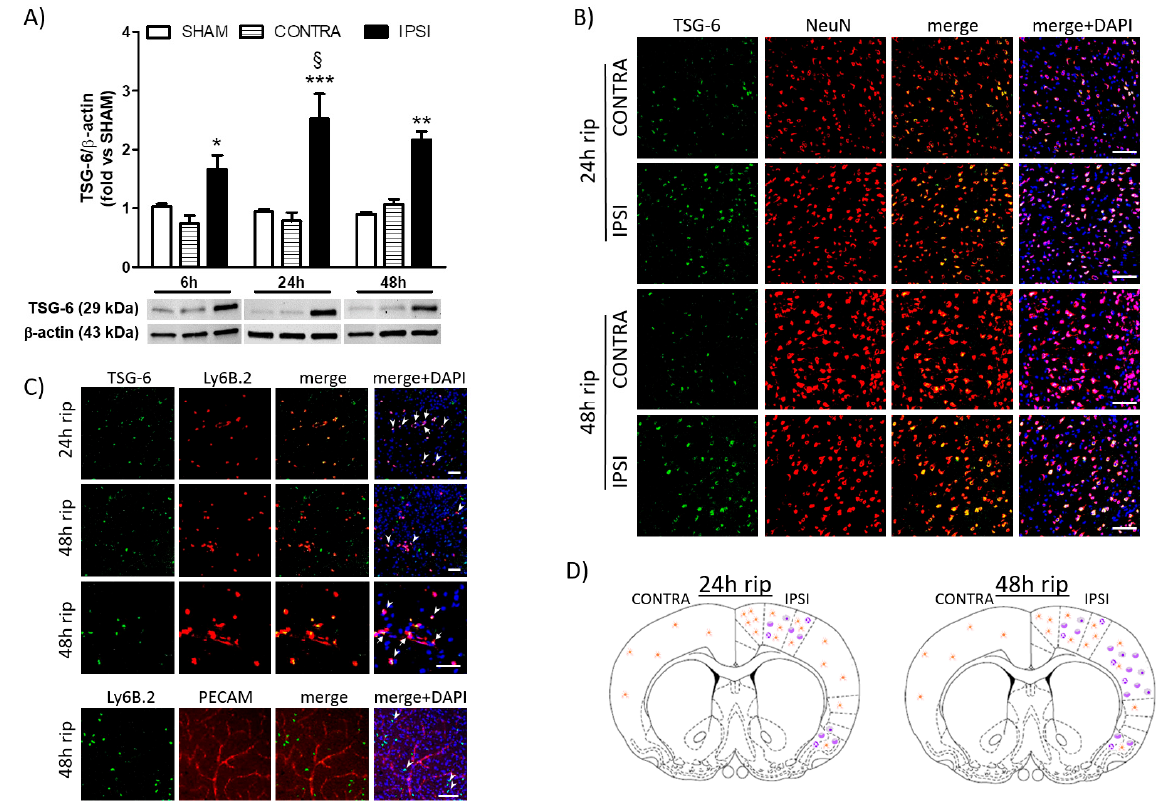
Figure 1. Tumour necrosis factor (TNF)- α -stimulated gene 6 (TSG-6) protein expression is elevated in the brain of mice subjected to transient MCAo. ( A ) TSG-6 protein expression levels detected by Western blotting in the ipsilateral (ischemic and IPSI) and contralateral (CONTRA) cortex of mice subjected to 1 h MCAo followed by 6, 24 or 48 h of reperfusion or mice subjected to sham surgery (SHAM). Data are expressed as means ± S.E.M.; * p < 0.05 vs. CONTRA 6 h, *** p < 0.001 vs. SHAM 24 h and vs. CONTRA 24 h, § p < 0.05 vs. IPSI 6 h, ** p < 0.01 vs. SHAM 48 h and vs. IPSI 48 h (two-way ANOVA followed by Bonferroni post-test; n = 6–8 mice per experimental group). ( B ) Representative immunofluorescence images showing colocalization (yellow overlapping in merge panels) of TSG6 (green fluorescence) with NeuN immunopositive neurons (red fluorescence) in the ipsilateral and contralateral cortex of mice subjected to 1 h middle cerebral artery occlusion (MCAo) followed by 24 or 48 h of reperfusion. Nuclei were counterstained with DAPI (blue signal). Scale bar = 150 µ m. ( C ) Representative immunofluorescence images showing colocalization (yellow overlapping in merge panels) of TSG6 (green fluorescence) with Ly6B.2 immunopositive myeloid cells (i.e., granulocytes and monocytes/macrophages, red fluorescence) in the ipsilateral cortex of mice subjected to 1 h MCAo followed by 24 or 48 h of reperfusion. The endothelium was labelled with anti-PECAM1 and the nuclei were counterstained with DAPI (blue signal). Arrows and arrowheads indicate TSG-6 immunopositive myeloid cells in perivascular spaces or infiltrating the brain parenchyma, respectively. Scale bar = 75 μ m. ( D ) Schematic representation of the regional and cellular distribution of TSG-6 immunoreactivity in the brain of mice subjected to 1 h MCAo followed by 24 or 48 h of reperfusion. Drawings were obtained from the typical distribution observed by microscopic examination of brain sections (0.70 mm anterior to Bregma) processed for immunofluorescence, as described in the methods section. NeuN and Ly6B.2 immunopositive cells that express TSG-6 are represented by orange or purple symbolic drawings, respectively.